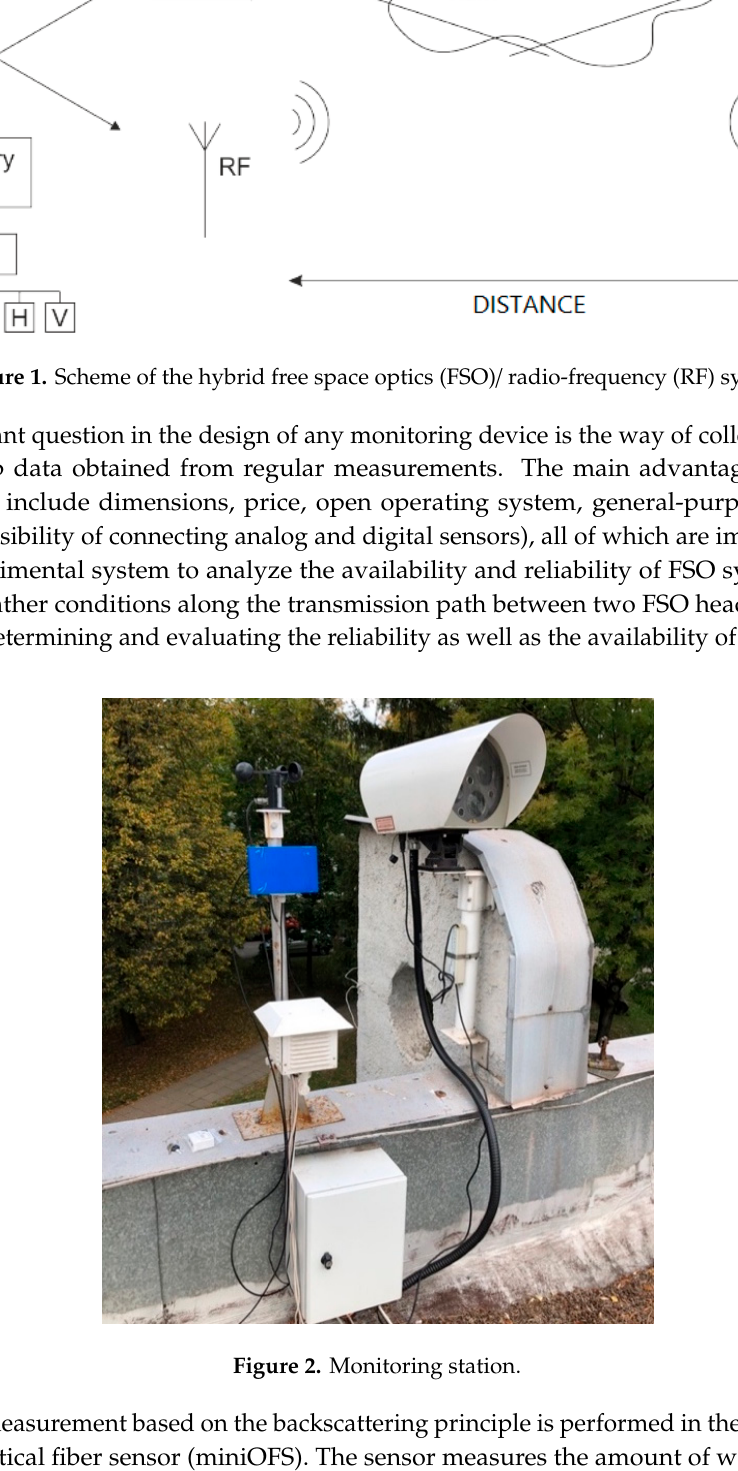
Figure 2. Monitoring station.